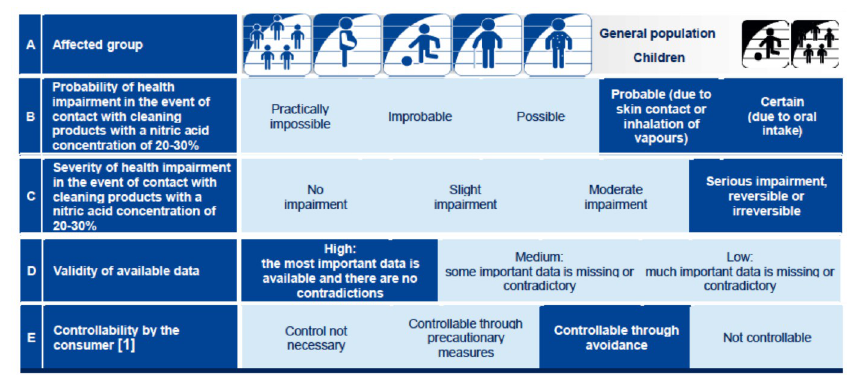
Fig 1. Example of the 2013 Risk Profile for nitric acid in cleaning